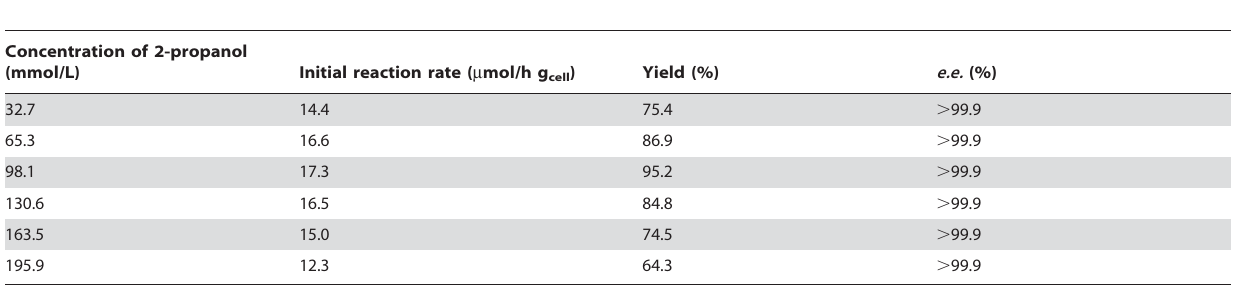
Table 3. Effect of co-substrate concentration on the bioreduction of TMSB with immobilized Candida parapsilosis cells.